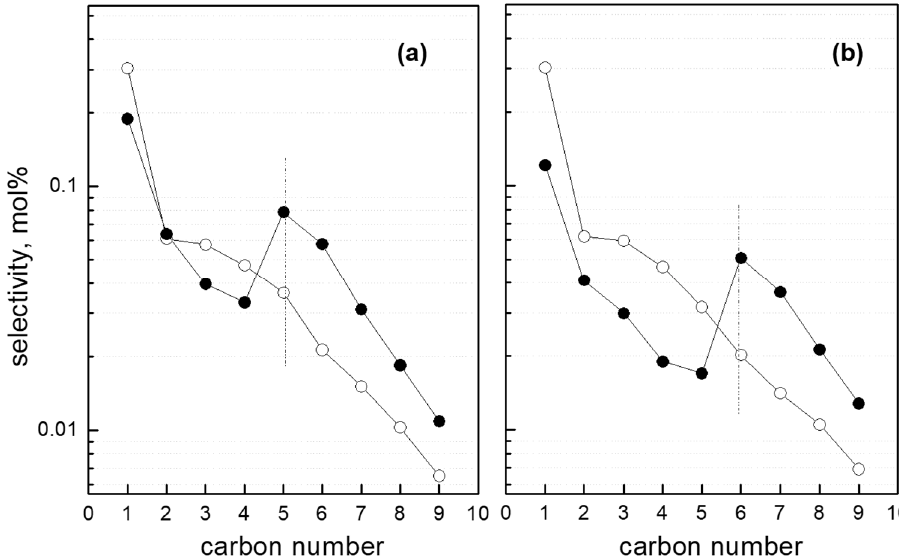
Figure 9. The effect of C 5 and C 6 alcohol addition on FTS product distribution. Reaction condition: T = 533 K, p = 0.8 Mpa, H 2 /CO = 8, and ( a , b ) with C 5 H 11 OH = 1.0 mL/h and C 6 H 13 OH = 1.5 mL/h, respectively. (– ● –) and (–o–) are the total hydrocarbon distributions with and without alcohol addition, respectively.